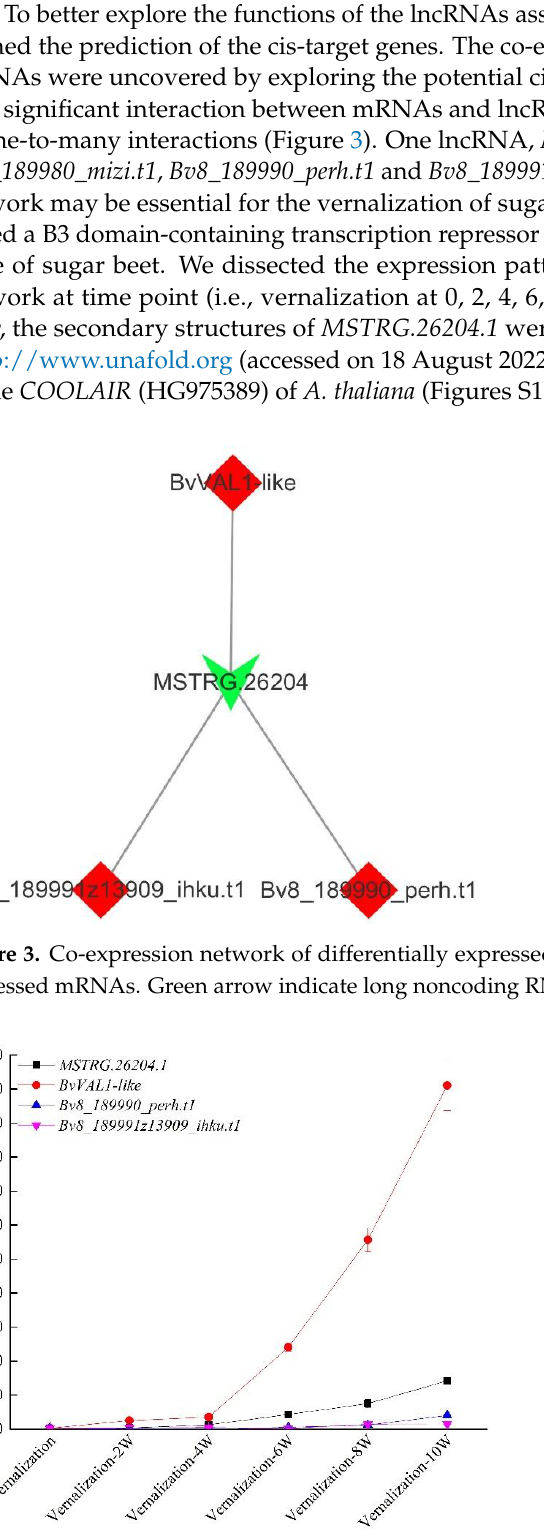
Figure 4. The expression patterns of long noncoding RNA ( MSTRG.26204 ) and mRNAs ( Bv8_189980_mizi.t1 : BvVAL-like , Bv8_189990_perh.t1 and Bv8_189991z13909_ihku.t1 ) (Table S1) in the co-expression network of sugar beet.